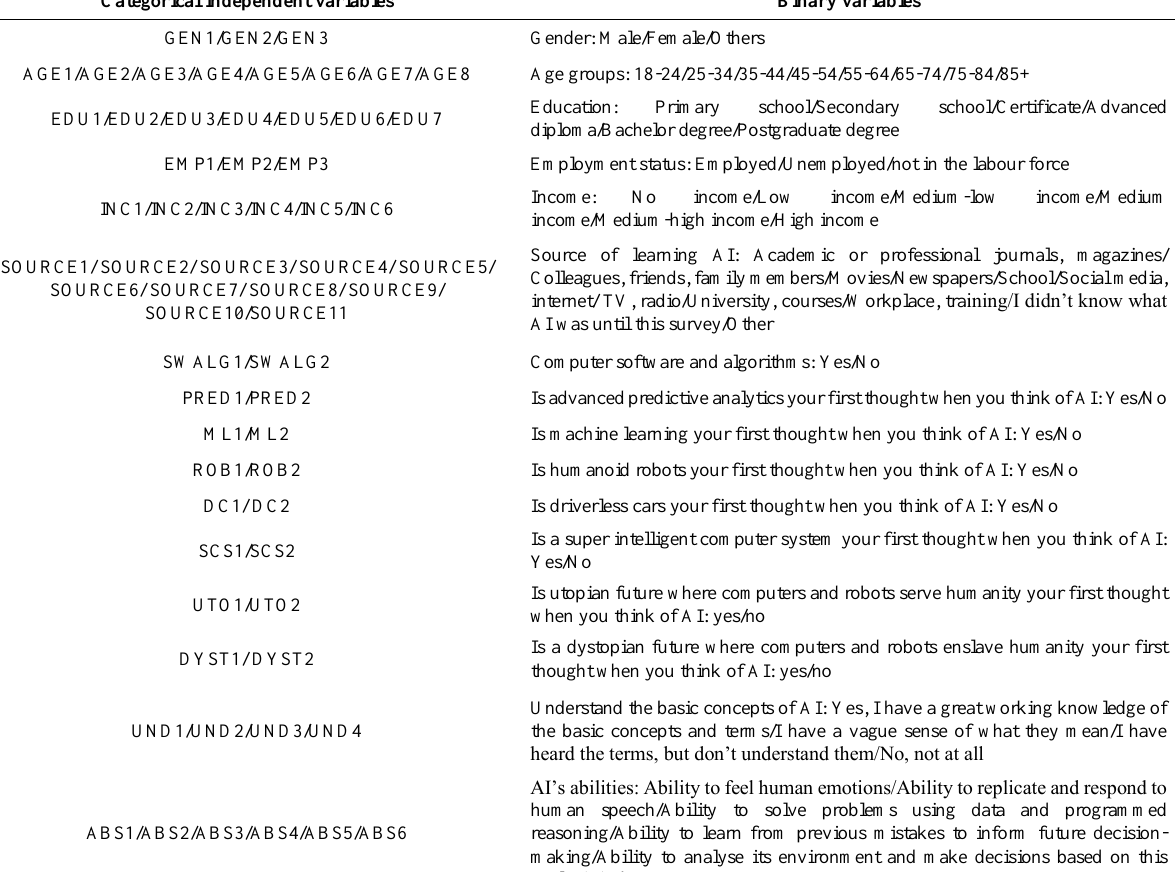
Table 3. Potential explanatory variables Categorical independent variables Binary